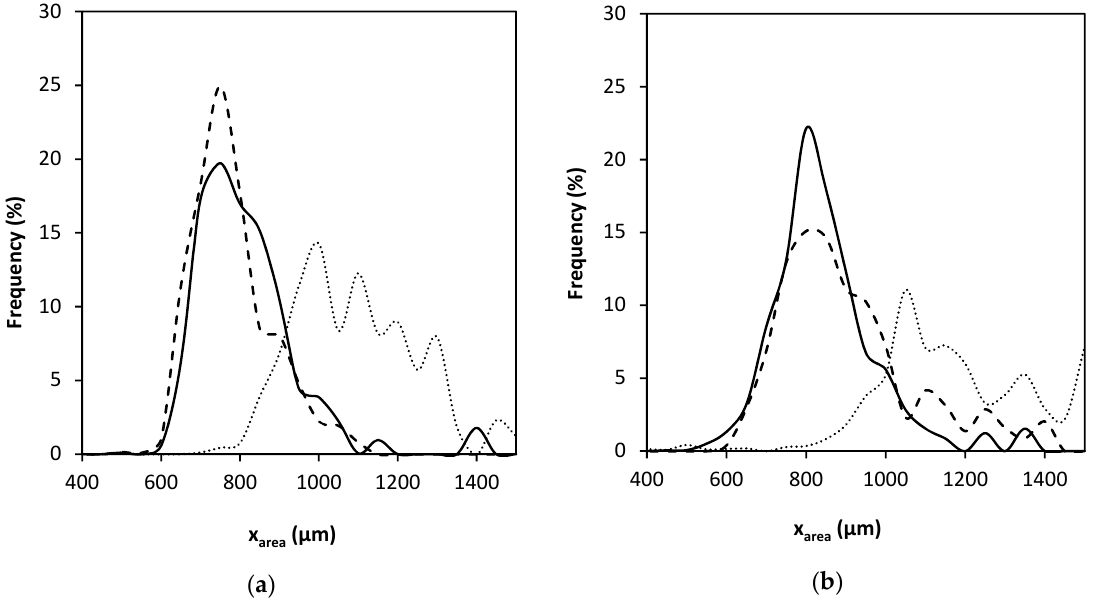
Figure 2. Particle size distribution obtained from the dynamic image analysis of chitosan aerogel particles processed using nozzle diameters of ( a ) 400 and ( b ) 500 μ m. Dotted, continuous, and dashed lines represent cutting disc velocities of 2000, 4000, and 6000 rpm, respectively.